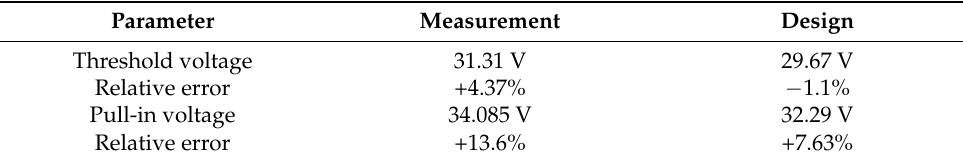
Table 4. Variation of threshold